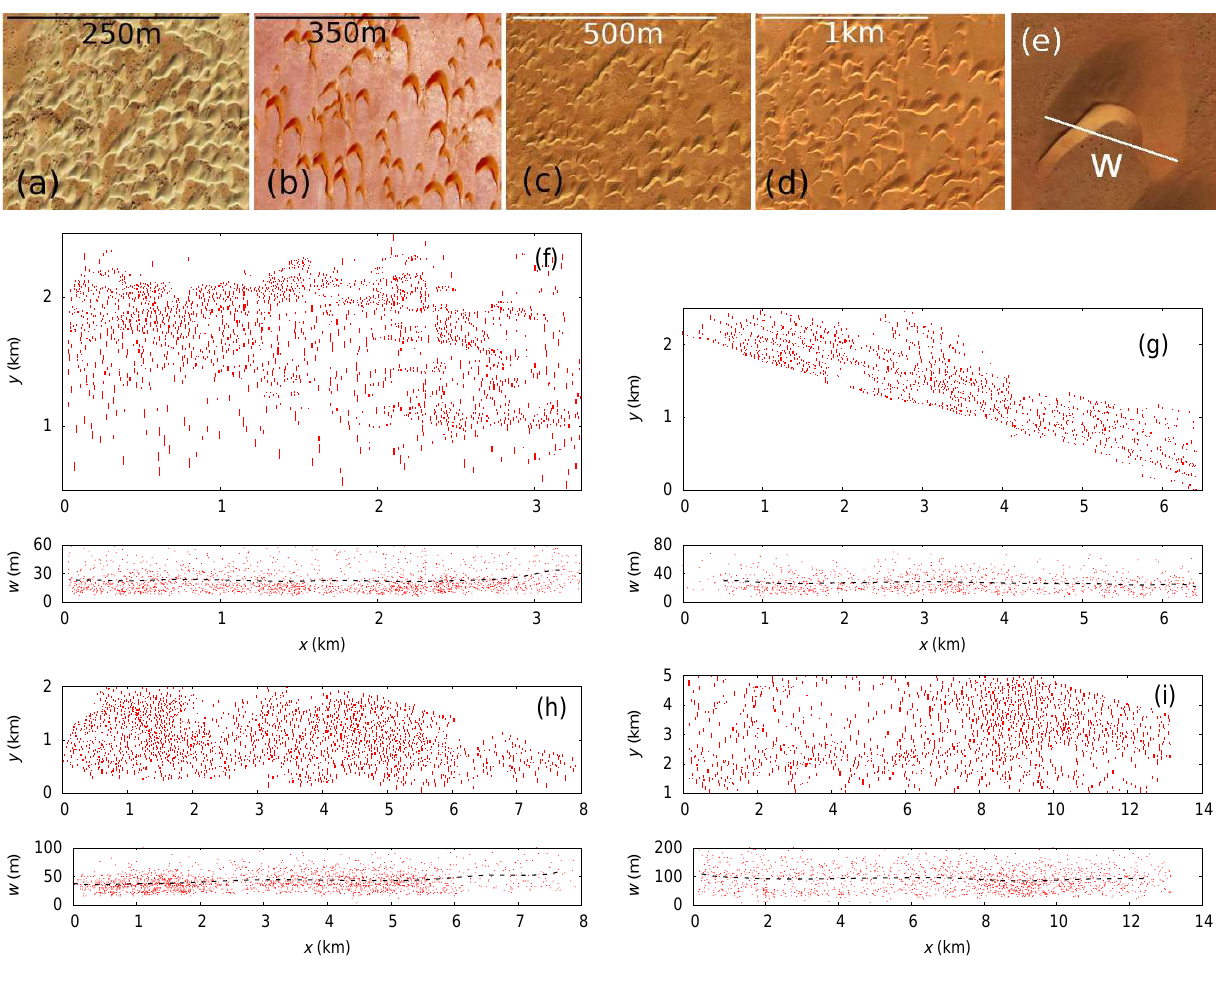
Fig. 1. (Color online) (a–d) Detail of the four measured dune field corridors localized in Western Sahara (wind blows from top to bottom): at (bottom left corner, top right corner, respectively) (a) 27 ◦ 32 0 37 00 N–13 ◦ 08 0 05 00 W; 27 ◦ 30 0 13 00 N–13 ◦ 08 0 35 00 W, (b) 27 ◦ 19 0 17 00 N–12 ◦ 35 0 05 00 W; 27 ◦ 15 0 43 00 N–12 ◦ 36 0 W, (c) 27 ◦ 20 0 48 00 N–13 ◦ 12 0 21 00 W; 27 ◦ 16 0 34 00 N–13 ◦ 13 0 35 00 W, (d) 27 ◦ 22 0 17 00 N– 13 ◦ 10 0 43 00 W; 27 ◦ 14 0 55 00 N–13 ◦ 11 0 10 00 W. (e) Dunes are represented by their “width line”. Illustrations reprinted from Duran et al. (2009) with authorization. (f–i) Measured barchan dunes in the four corridors. The x -axis is oriented along the wind direction (from left to right) which is also the direction of dune movement. Lower panels show the dune width as function of their x -position, where dashed lines indicate the average dune size along the transverse y -direction. In all pictures, the North points up. Satellite data: 2006